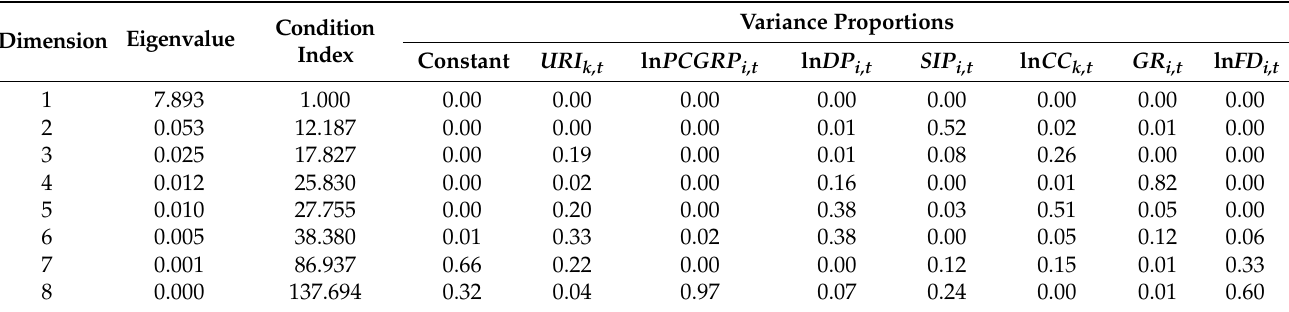
Table 3. Collinearity diagnostics among the control variables. Dimension